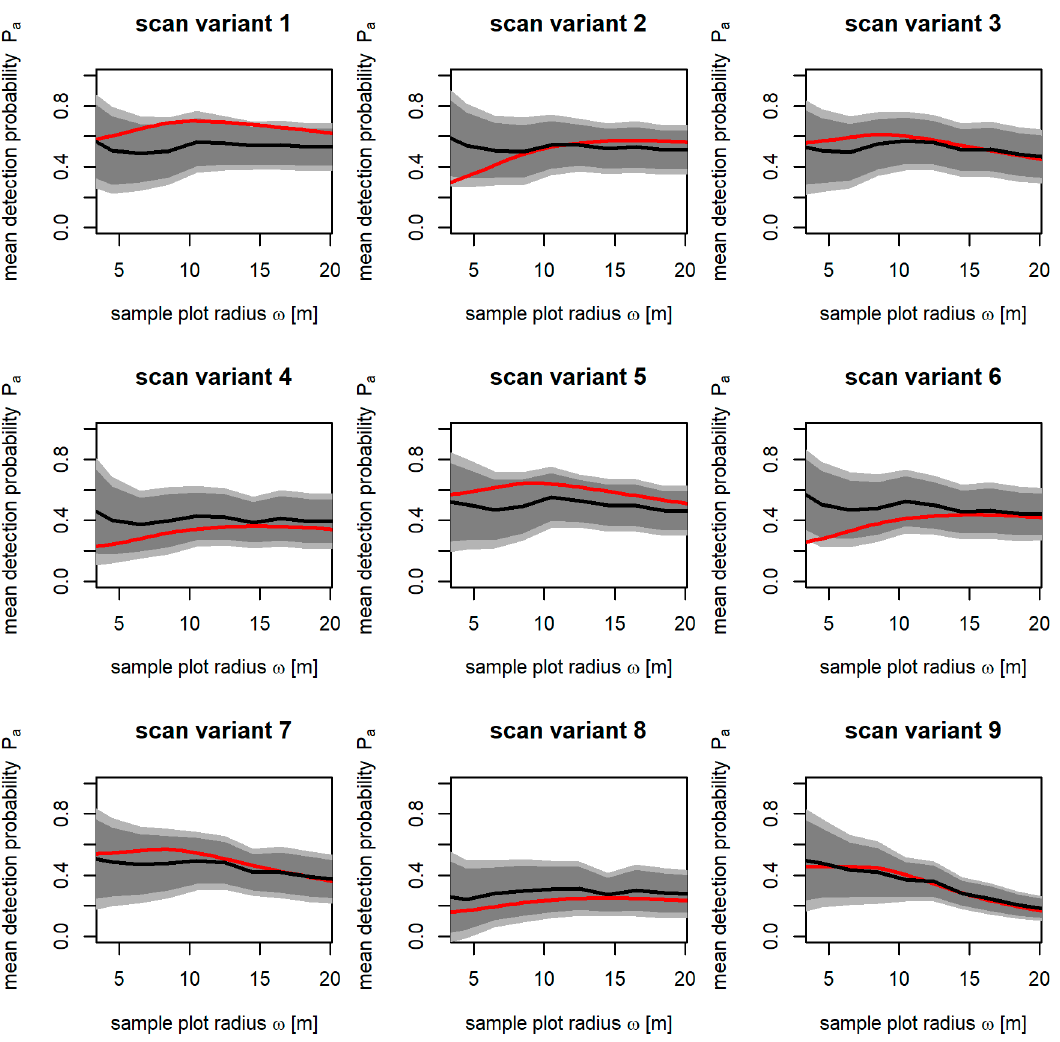
Figure A2. Mean detection probability P a of small trees (5 cm ≤ dbh < 20 cm) for different sample plot radii ω and all scan variants described by Gollob et al. [43]. The black line represents the observed data; the red line represents the model prediction. The light and dark grey areas are the 99% and 95% confidence intervals computed from the observed data, respectively.